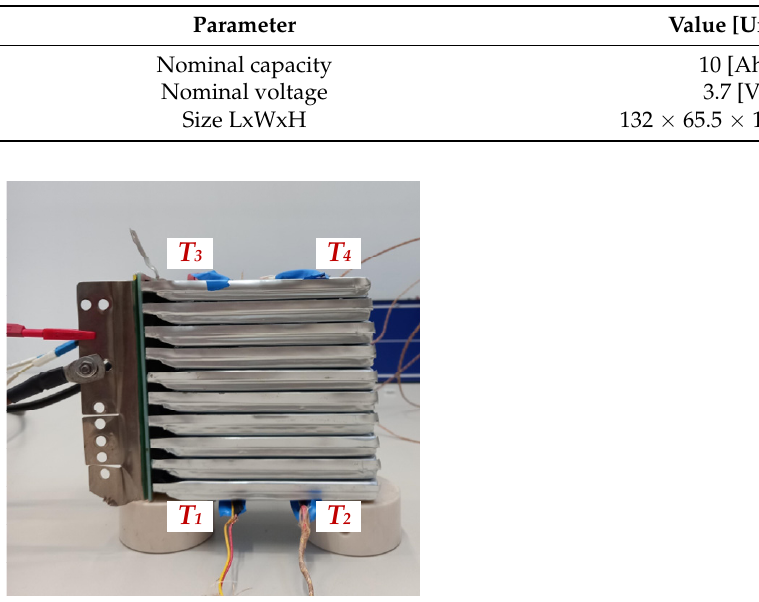
Figure 1. Ten-cells battery pack with the indication of the thermocouples positioning. Table 1. Battery cell